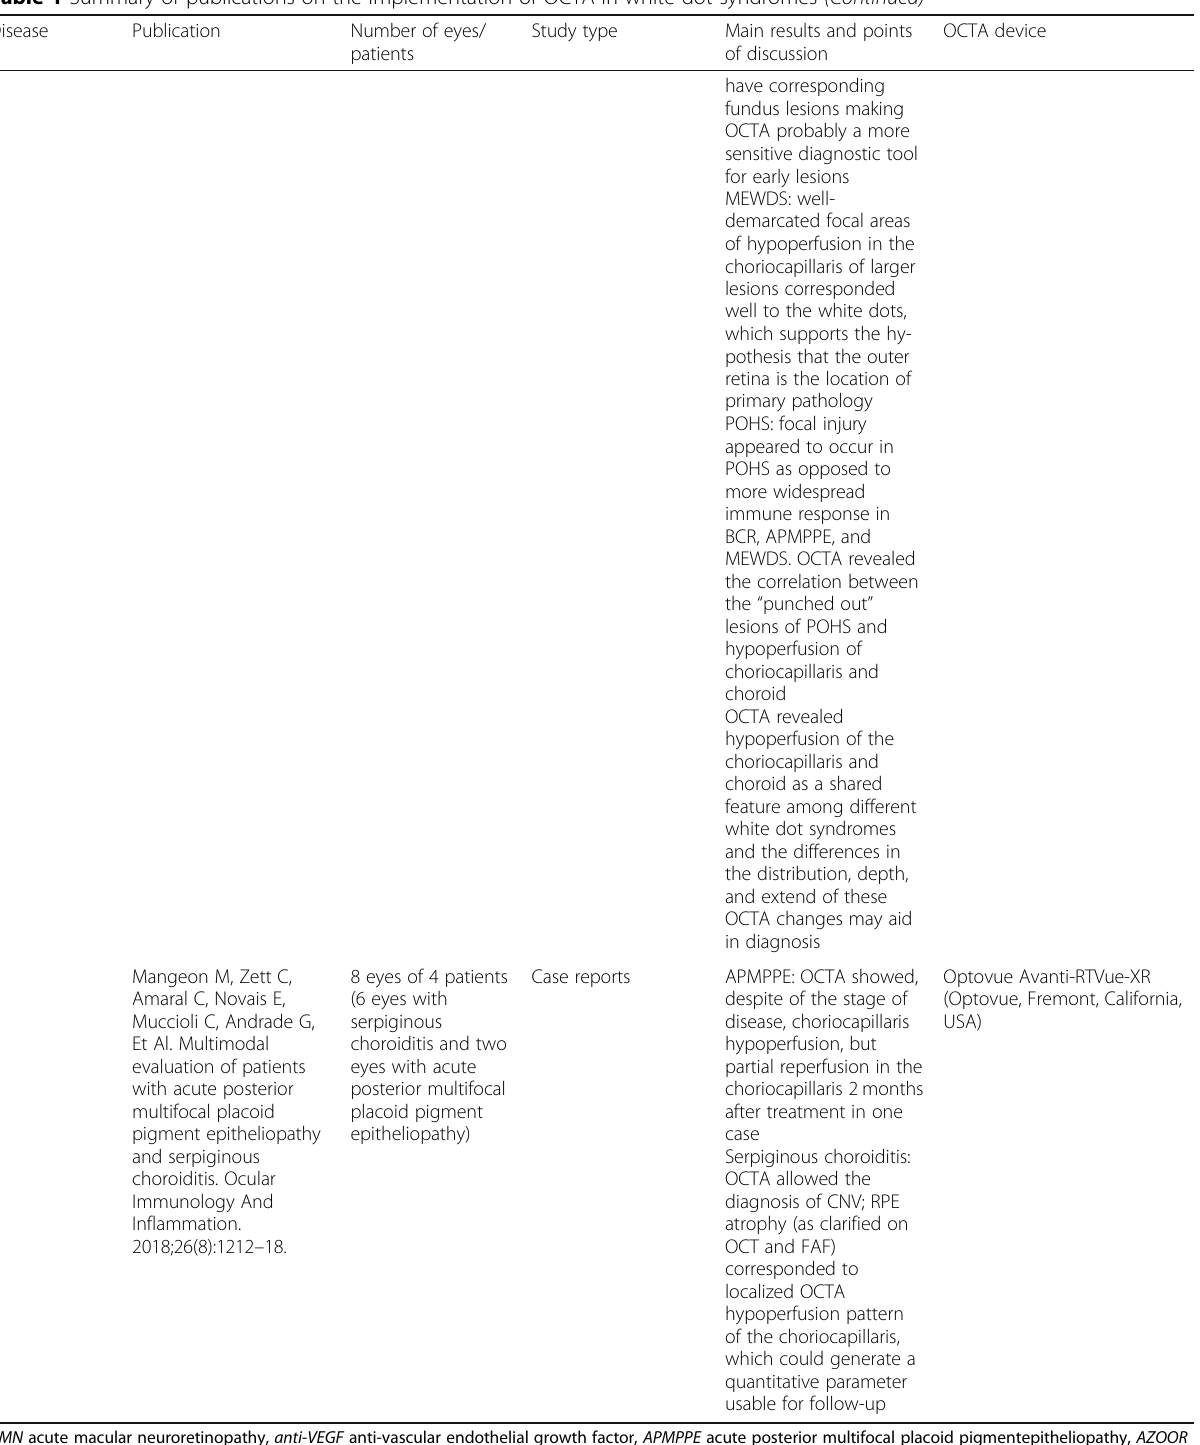
Table 1 Summary of publications on the implementation of OCTA in white dot syndromes (Continued)